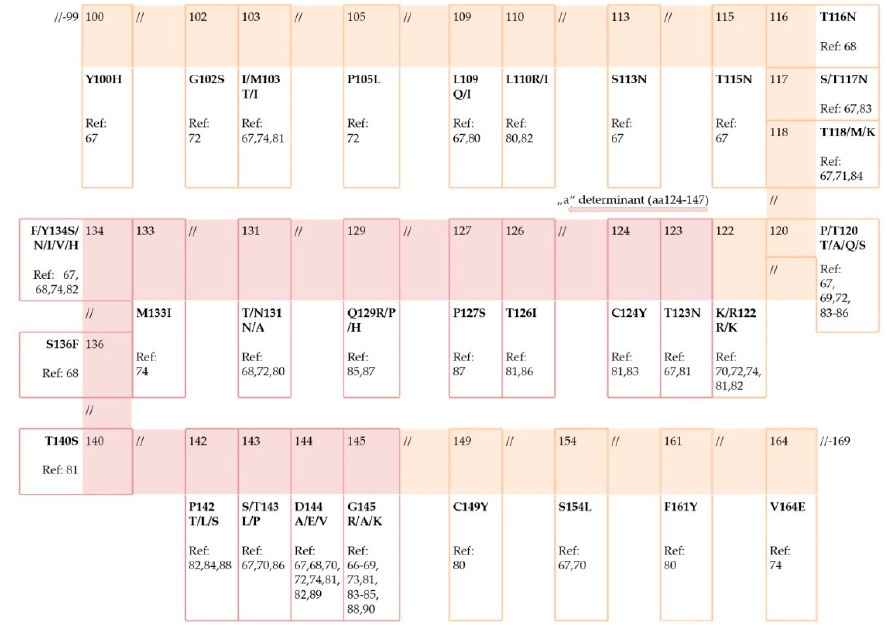
Figure 1. HBsAg mutations within major hydrophilic region (MHR) reported in patients suffering from HBV reactivation; in orange—MHR, aa 99–169; in pink—“ a ” determinant within MHR, aa124–147; Ref—reference [66–74,80–90].